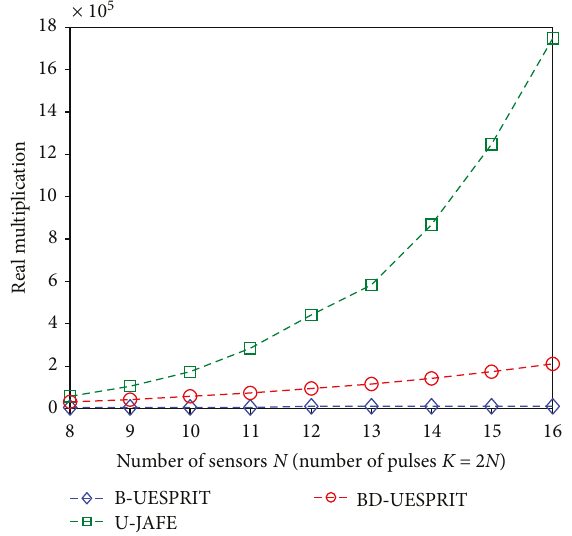
Figure 7: Complexity comparison against number of sensors N (number of pulses K = 2 N